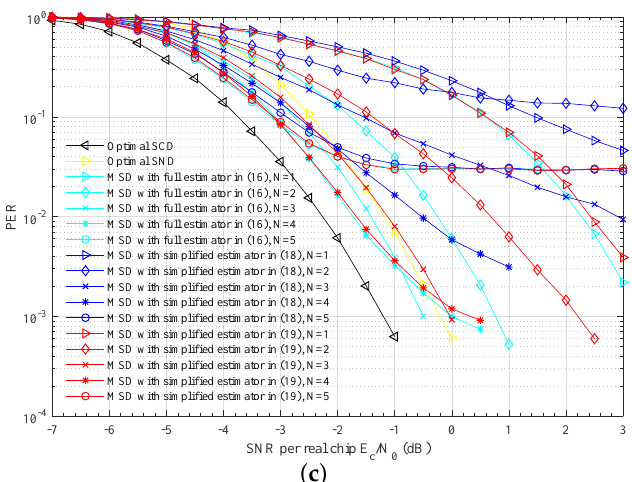
Figure 5. Detection performance impact of the truncated number N of differential chips under proposed MSD scheme over a pure AWGN channel when the observation window length j = 3. ( a ) PER performance with full estimator in (16); ( b ) PER performance with simplified estimator in (18); ( c ) PER performance with simplified estimator in